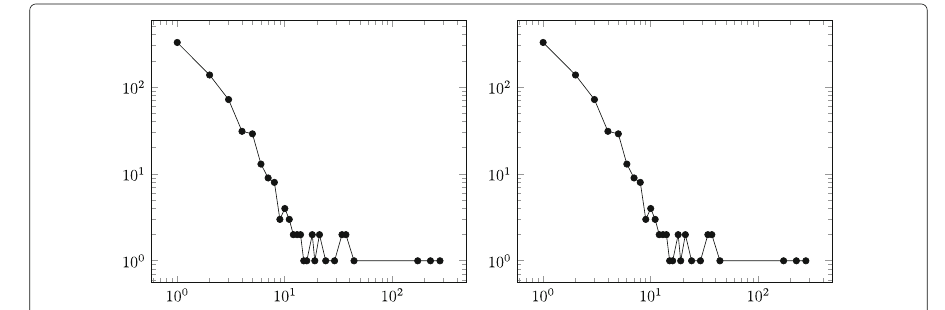
Fig. 9 Outdegree distribution of M (left) and S (right)